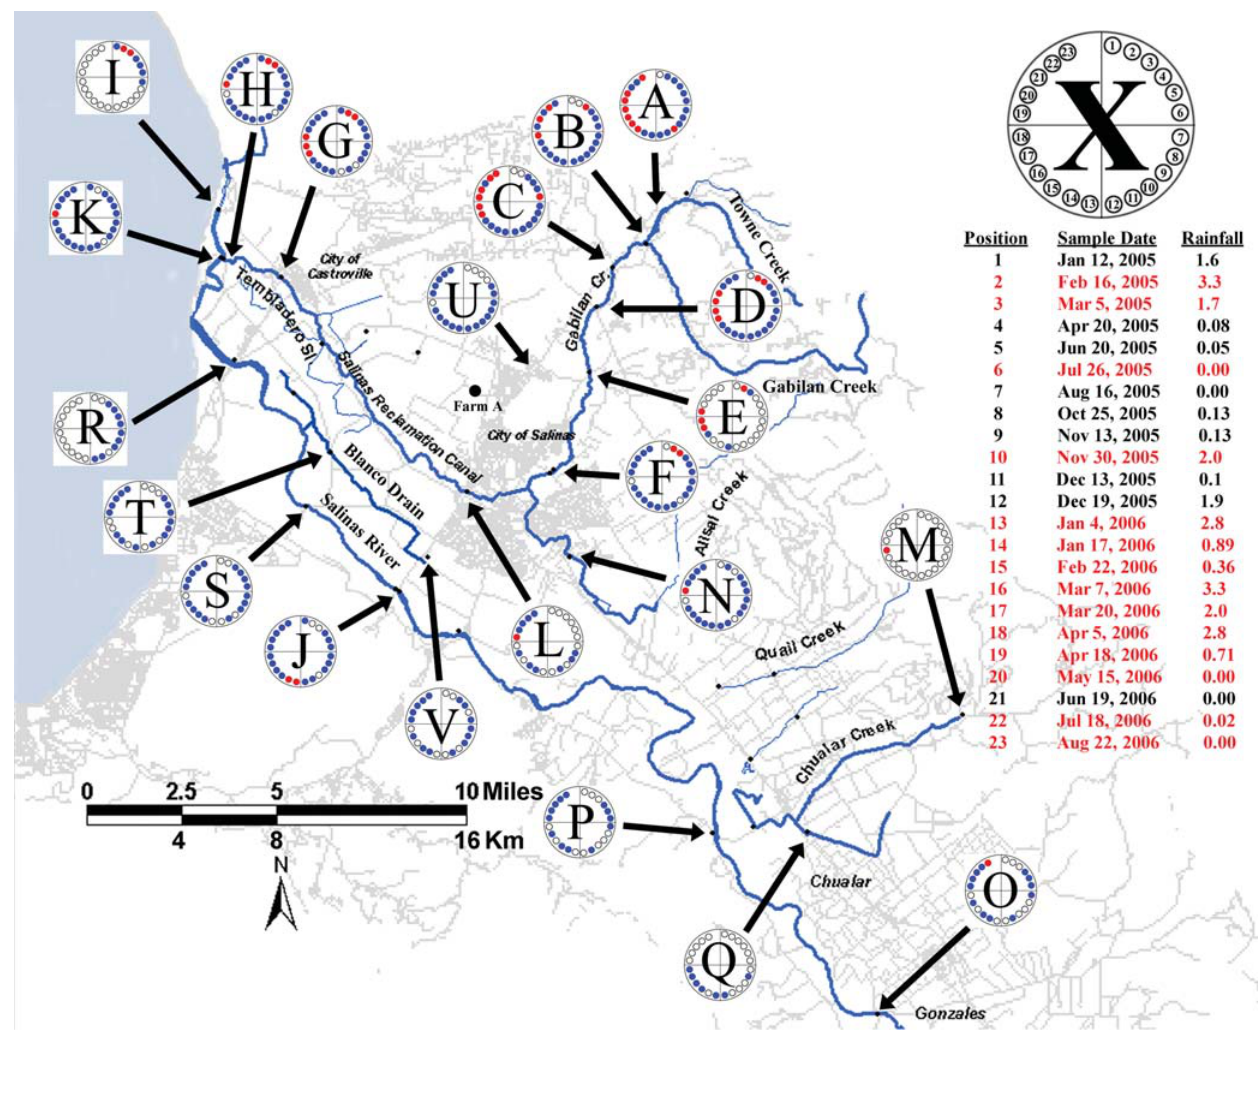
Figure 1. Map of Salinas, CA region showing sample locations. Farm A is marked as a black dot. The circle marked with ‘‘X’’ is coded by positions numbered clockwise 1 to 23 and representing the sampling dates show in the list below the circle. The approximate rainfall in cm for the 5 days prior to sampling is shown in the list. Dates indicated in red text indicate at least one EcO157 strain was isolated on that date. Circles on the map designated ‘‘A’’ through ‘‘V’’ correspond to the locations where samples were obtained; these are also listed in Table S1. Open circles within the ‘‘Location circle’’ designate that no sample was obtained on that date; blue circles designate that a sample was obtained, but no EcO157 strain was isolated; and red circles designate that a sample was obtained, and at least one strain of EcO157 was